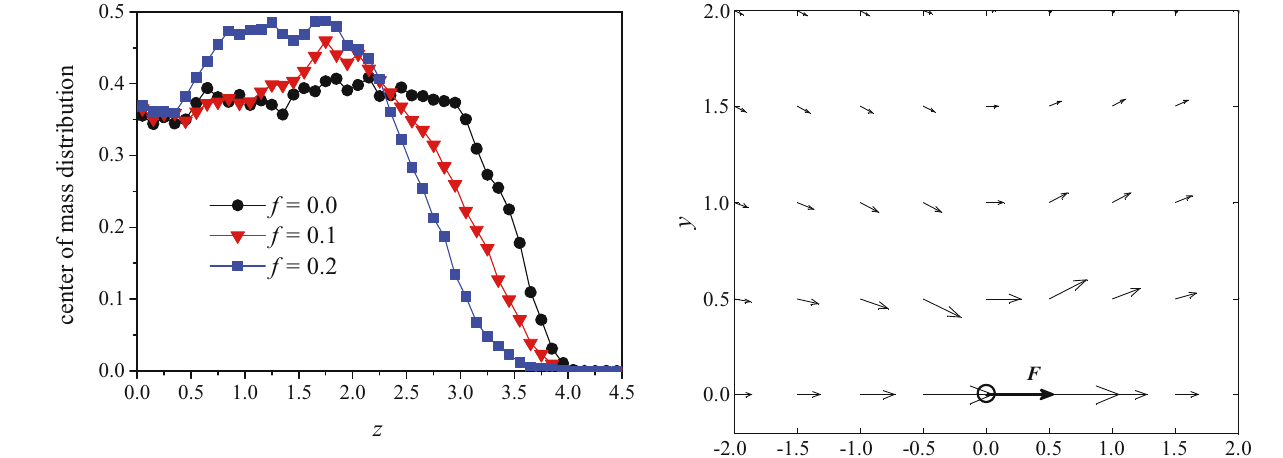
Figure 10: The wormlike chains ’ center of mass distribution across the slit for varying values of the driving force: f = 0, 0.1, and 0.2.